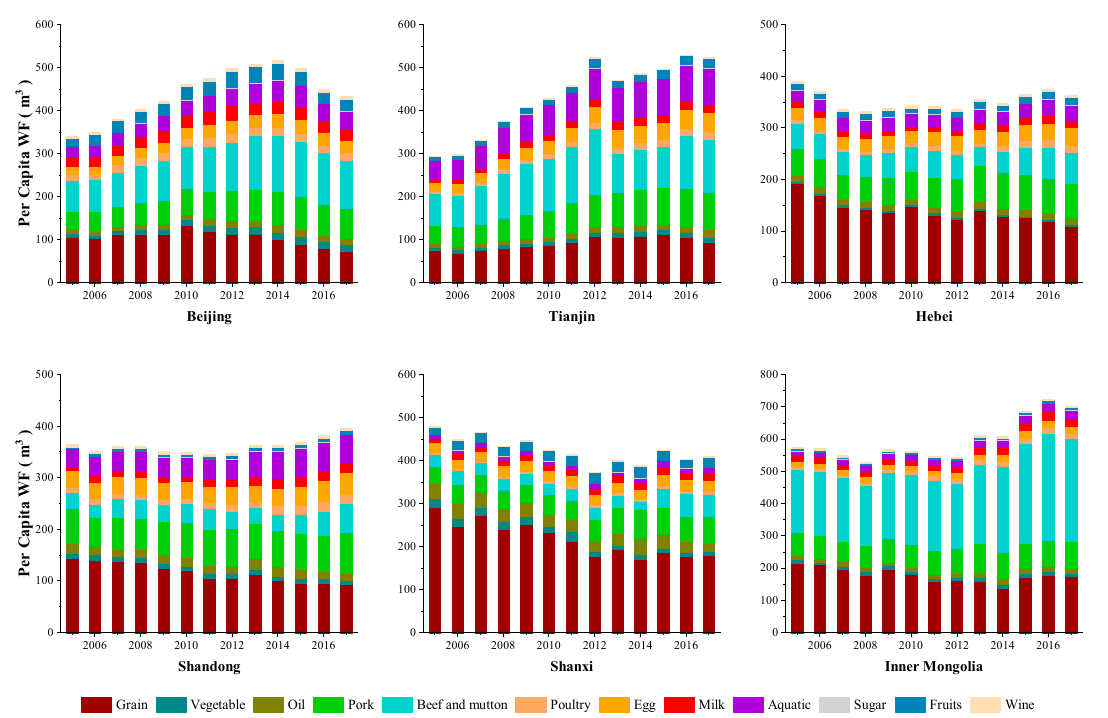
Figure 3. Per capita water footprint (WF) of food consumption in North China (2005–2017).